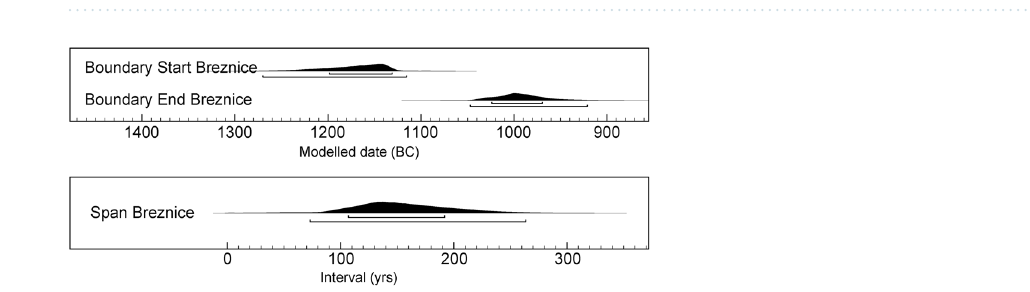
Figure 2. Workflow diagram of the interdisciplinary research.